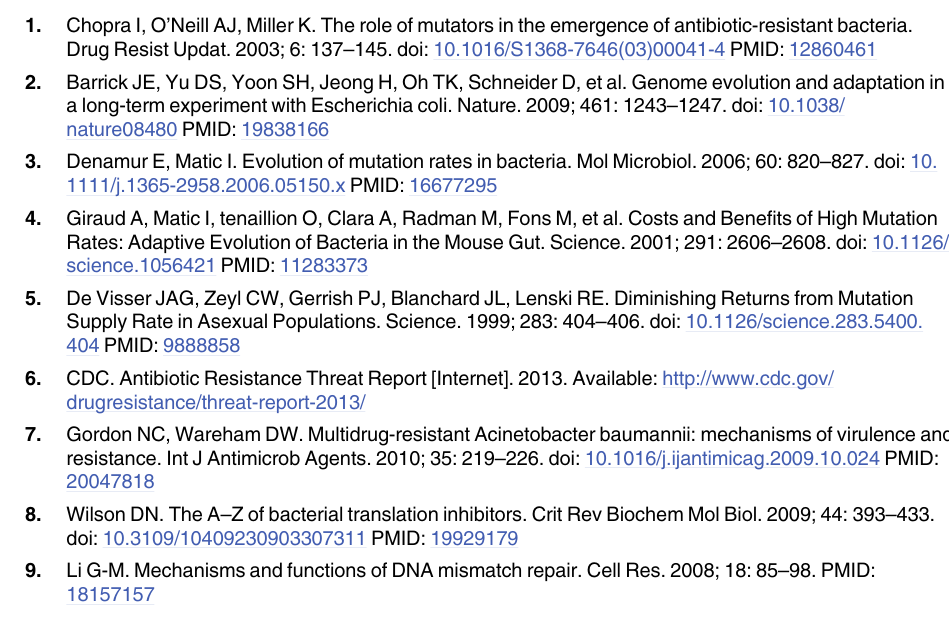
between AB210 and AB210M, the phenotypic assays and clustering analysis, identification of the large deletions, additional genes that passed the bioinformatic filters, mutations in the ade gene family, and mutations in other TGC resistance